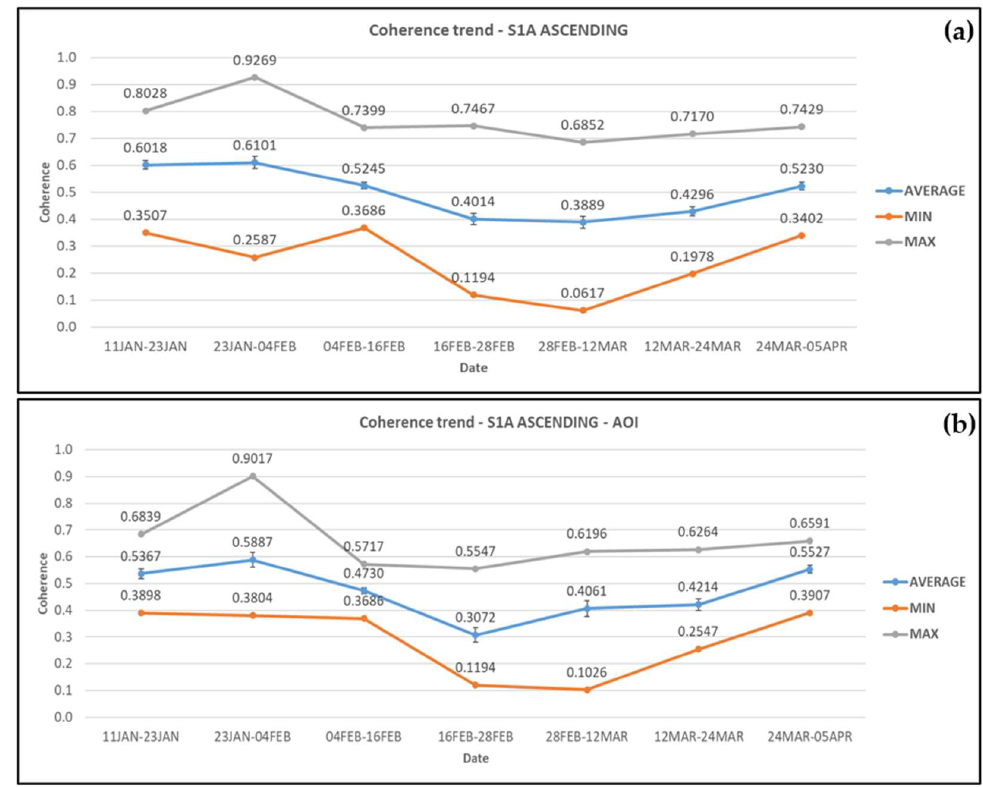
Figure 4. Coherence changes obtained from Sentinel-1A ascending satellite images for ( a ) the wider area and ( b ) the AOI. Error bars can be seen in the average coherence values.